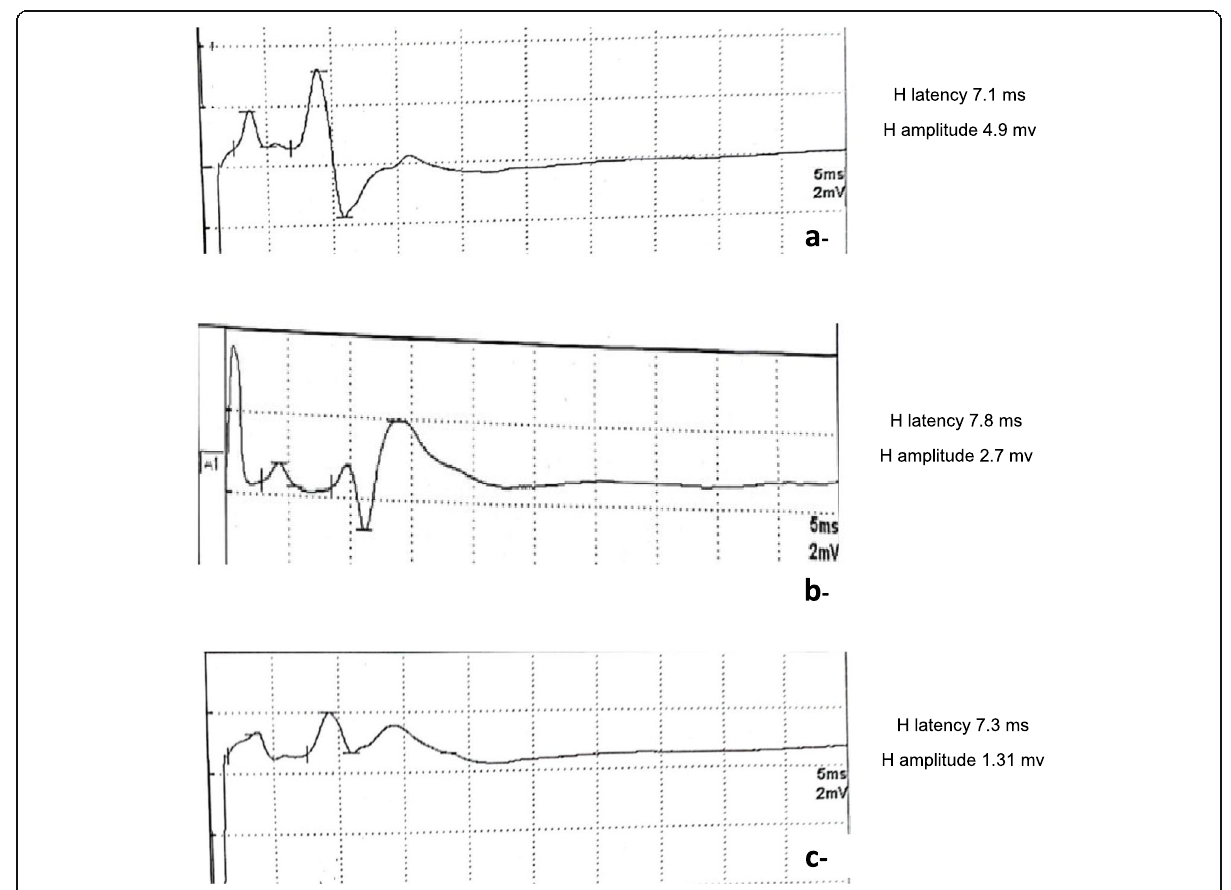
Fig. 2 H reflex in group I. a Before treatment. b Two weeks after treatment. c Follow-up (3 months after treatment)